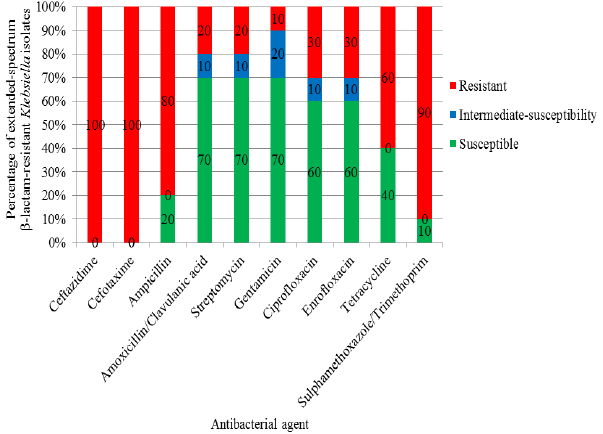
Fig. 1. Prevalence of extended-spectrum β-lactam-resistant enterobacterial isolates from dogs